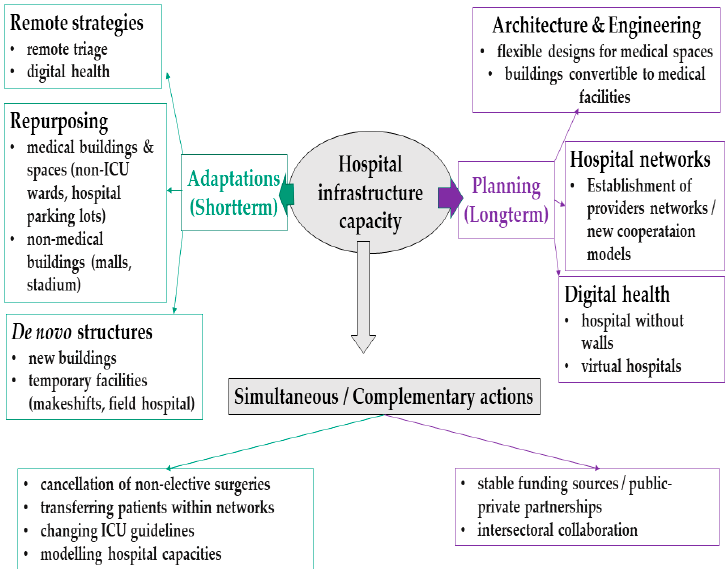
Figure 9. Graphical representation of hospital infrastructure adaptation and planning during the COVID-19 pandemic.